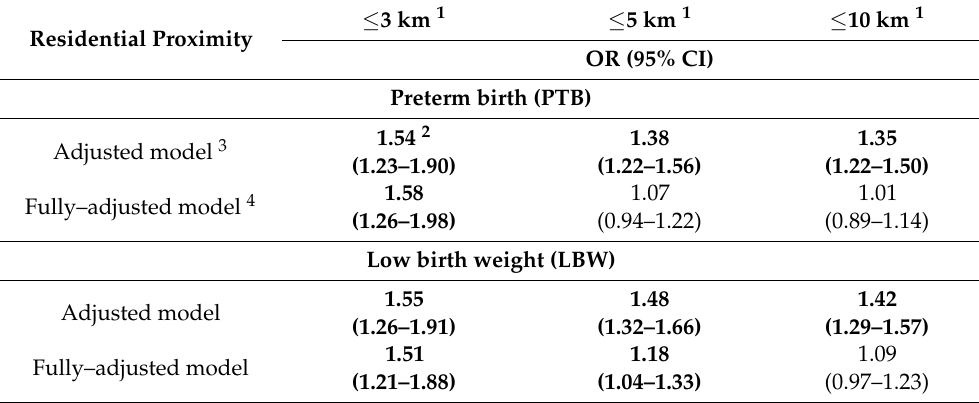
Table 3. Associations between adverse birth outcomes and mother’s residential proximity to oil shale industries in